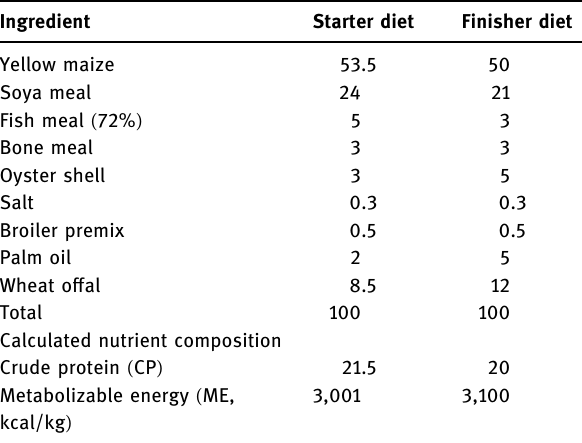
Table 1: Experimental diet composition and its proximate analysis ( % ) Ingredient Starter